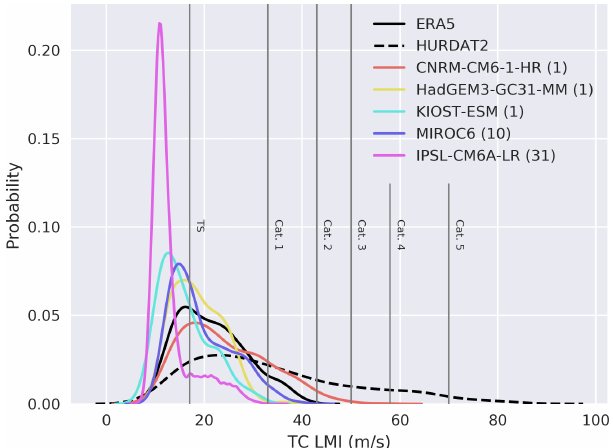
Figure 4. TC lifetime maximum intensity distributions for the historical (1984–2014) period for selected CMIP6 models, ERA5 (black, solid), and HURDAT2 (black, dashed). Only TCs forming during the North Atlantic hurricane season are considered. Den- sities are approximated as kernel density estimates. Vertical grey lines represent the different categories on the Saffir–Simpson scale. The number of ensemble members used for each model is shown in brackets in the